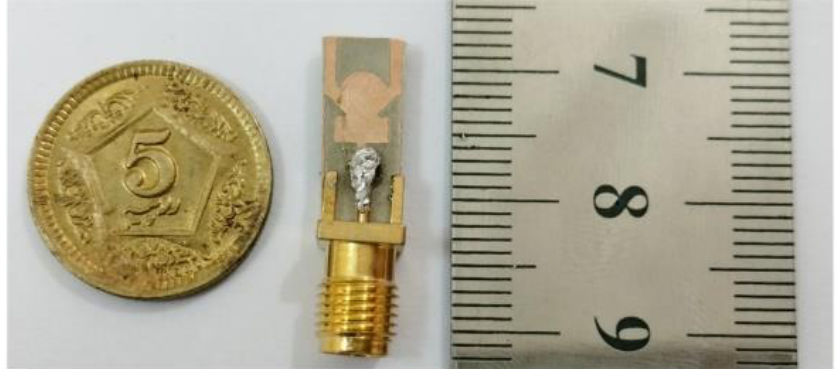
Figure 4. Fabricated prototype of wideband antenna.